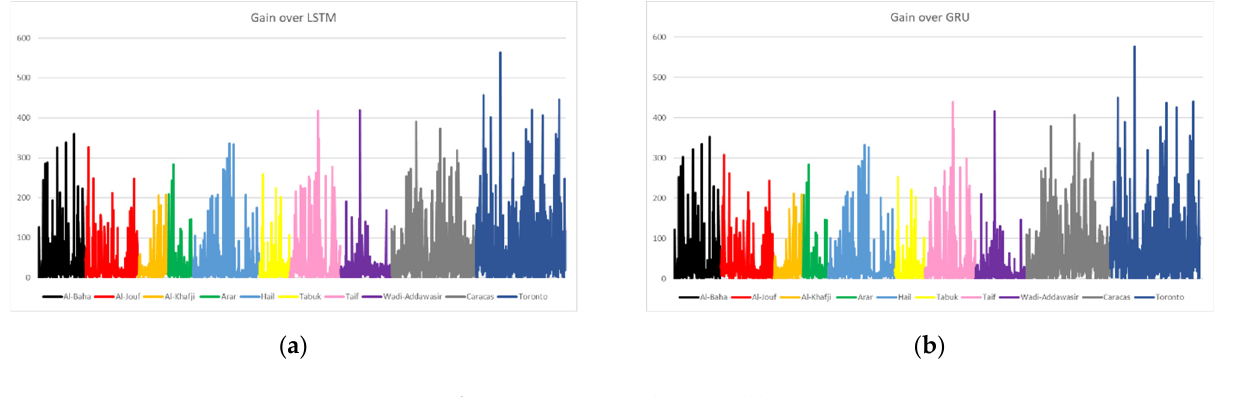
Figure 41. Gain of SENERGY over: ( a ) LSTM; ( b ) GRU.